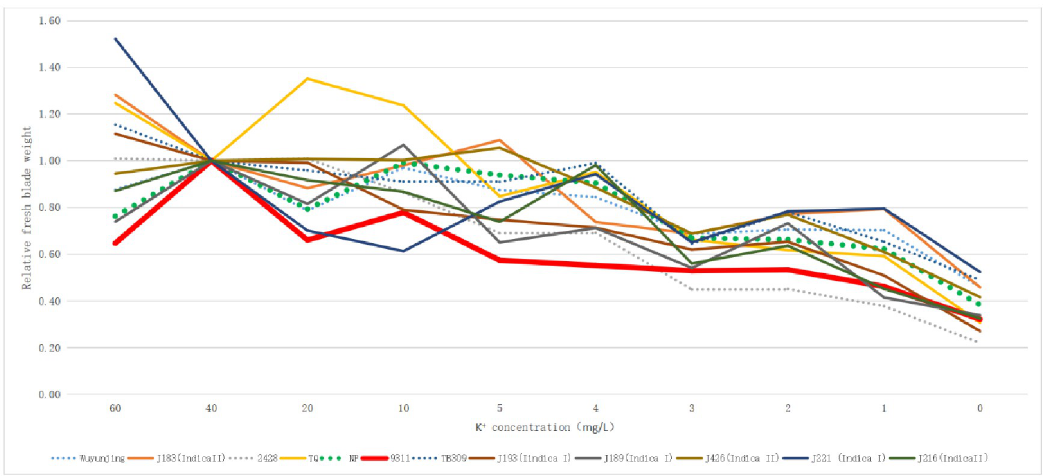
Fig 3. Relative fresh blade weight of twelve rice varieties in different potassium concentration culture solution. The dotted line is japonica rice and the solid line is indica rice.